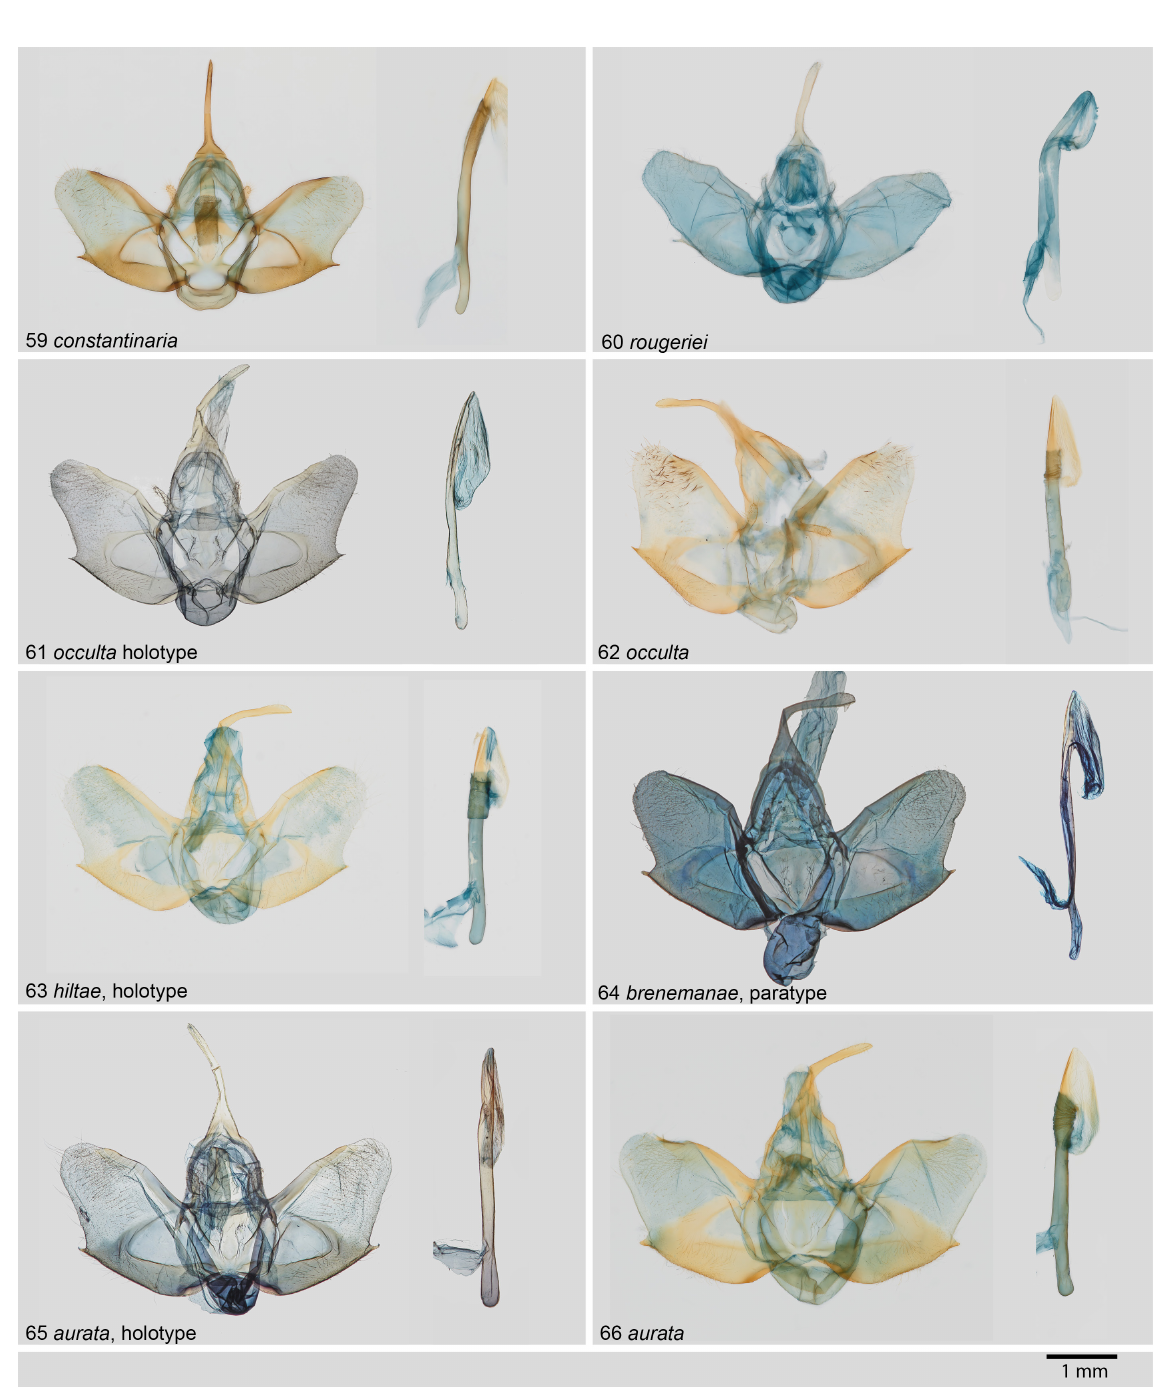
Figs 59–66. Male genitalia (left = valves; right = aedeagus). 59 . Callipia constantinaria Oberthür, 1881 (C-0085, COI data). 60 . C. rougeriei sp. nov., paratype (C-0070, COI data). 61 . C. occulta Warren,